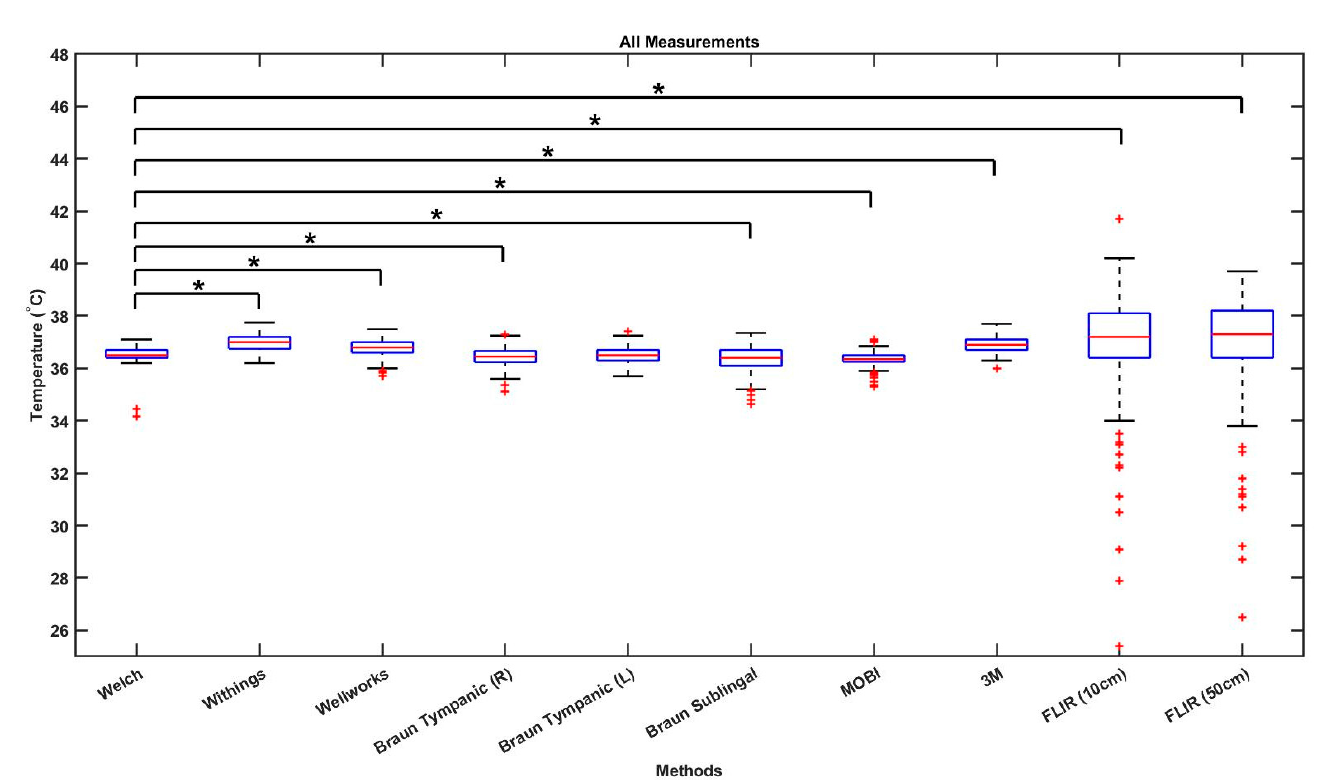
Figure 3. Boxplot of all temperature readings.